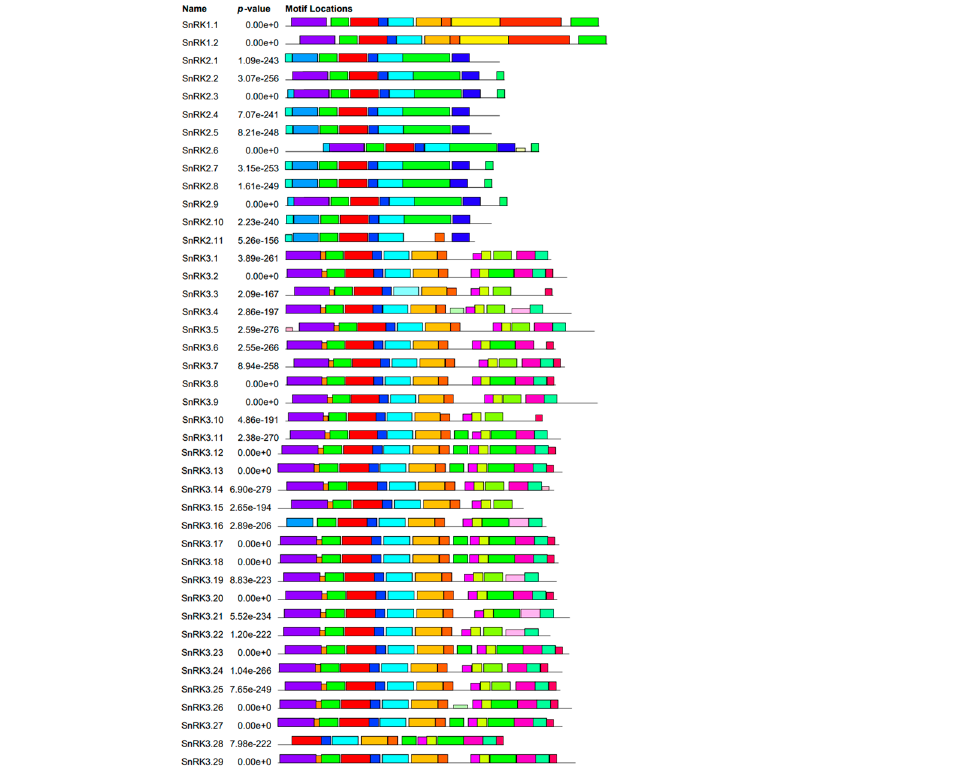
Figure 4. Schematic representation of putative conserved motifs identified MEME in Phaseolus SnRK proteins. Putative conserved motifs shared by Phaseolus SnRK proteins were mined in MEME program. Twenty-five motifs are indicated by differently coloured boxes and the regular motif sequences are shown in the Table S4.